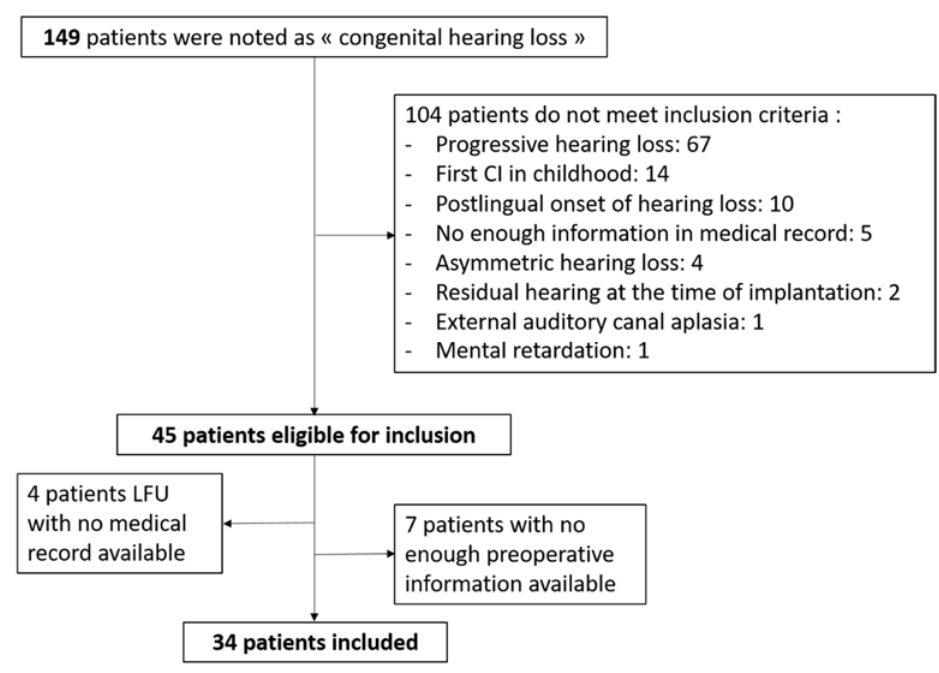
Figure 1. Flowchart of patient inclusion.